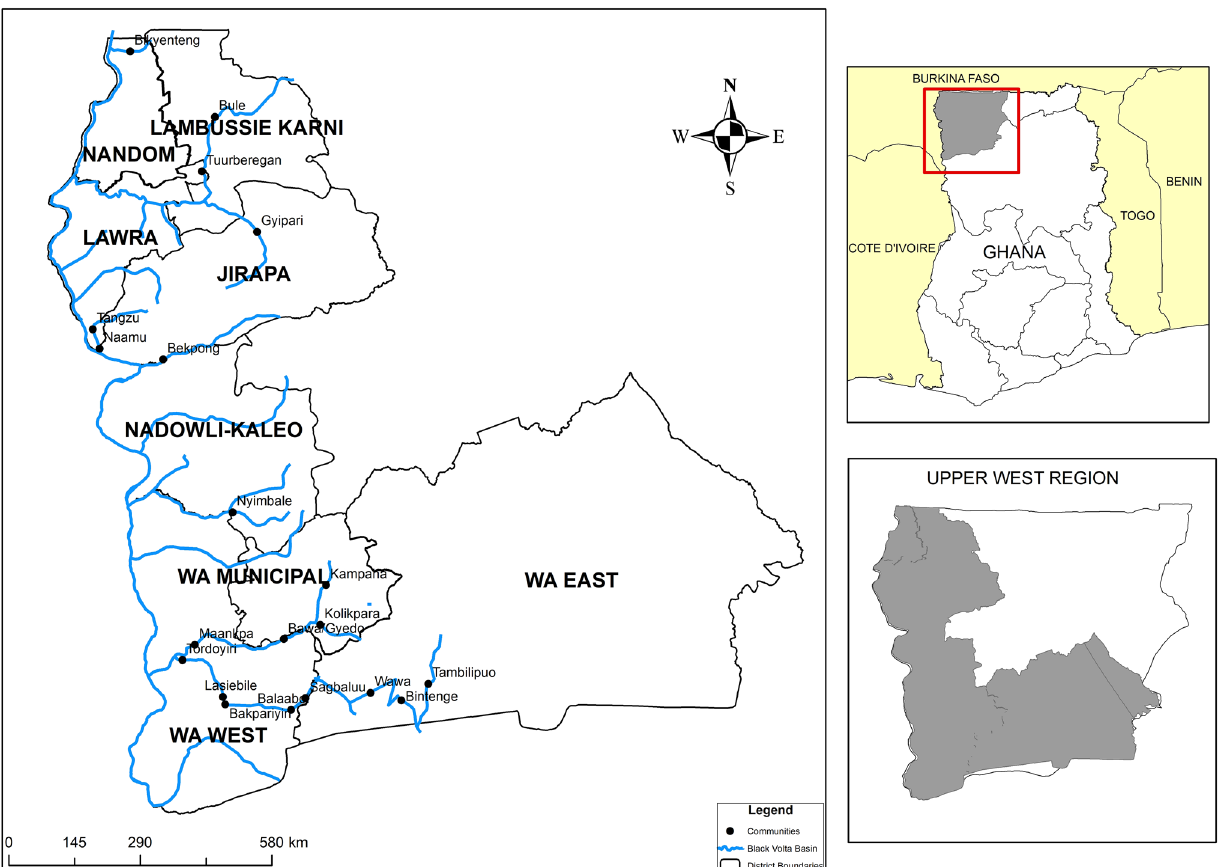
Fig. 1 Map of Ghana showing the district capitals and the selected communities for study along the